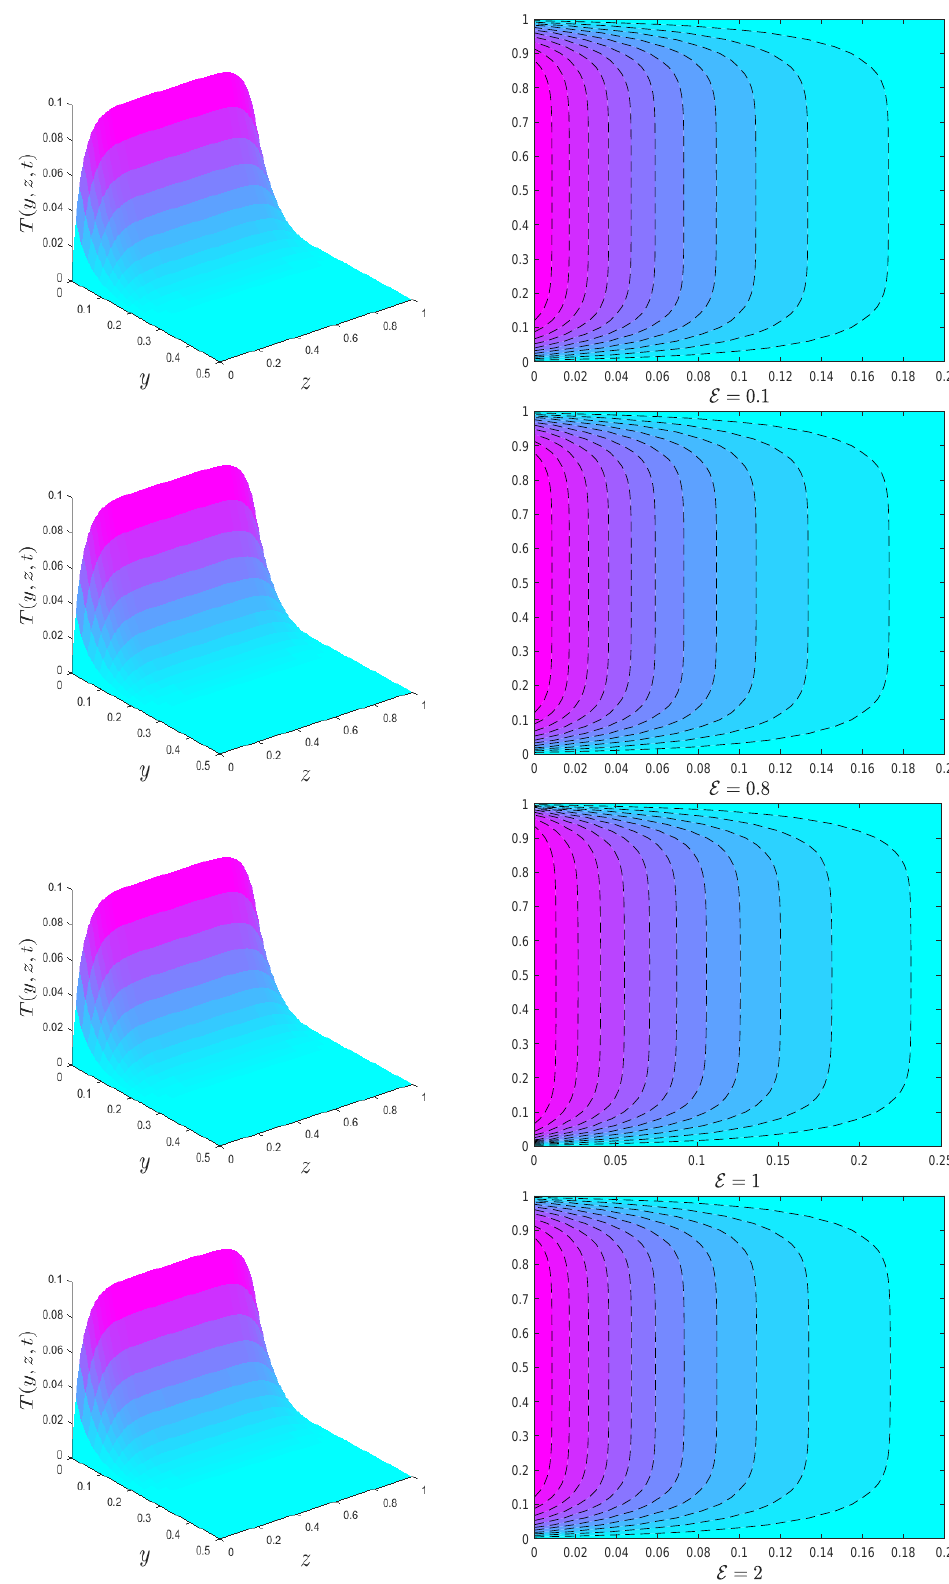
Figure 9. Temperature profile for different values of dissipation parameter E